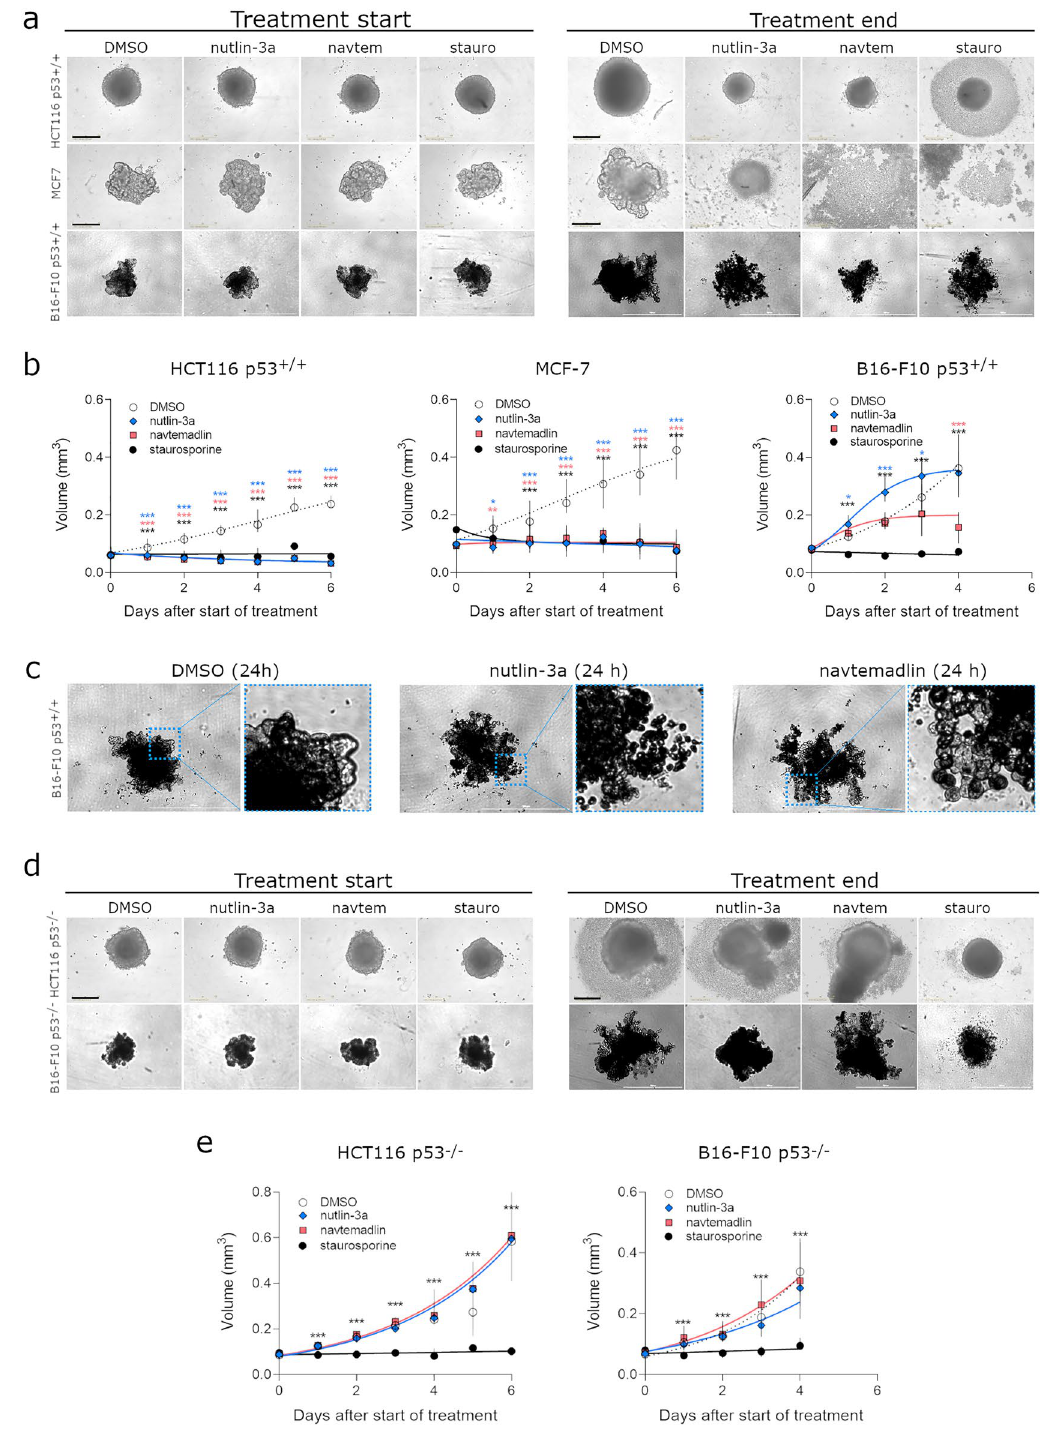
Figure 5. MDM2 inhibitors reduce growth of human and mouse p53 WT cells cultured as spheroids. ( a ) Brightfield images of HCT116 p53 +/+ , MCF7 and B16-F10 p53 +/+ spheroids at start and end of treatment. ( b ) Growth curves of p53 WT spheroids treated with DMSO, nutlin-3a (human cells: 5 μM; mouse cells: 10 μM), navtemadlin (human cells: 1 μM; mouse cells: 2 μM), and staurosporine (human cells: 2 μM; mouse cells: 5 μM). Black scale bars = 400 µm; white scale bars = 1000 µm. ( c ) Brightfield images of B16-F10 p53 +/+ spheroids after 24 h treatment with DMSO, nutlin-3a and navtemadlin. ( d ) Brightfield images of treated HCT116 p53 −/− and B16F10 p53 −/− spheroids at start and end of treatment. ( e ) Growth curves of HCT116 p53 −/− and B16F10 p53 −/− spheroids treated with DMSO, nutlin-3a, navtemadlin and staurosporine. Data points represent the median value ± 95% CI (n = 6–18 spheroids/treatment) from 2 to 3 independent experiments. Statistical significance was assessed by mixed-effects ANOVA with matching followed by post-hoc Dunnett’s correction for multiple testing (unpaired, two-tailed, α = 0.05). Adjusted P values from the Dunnett’s test are indicated (* P < 0.05; ** P < 0.01; *** P <